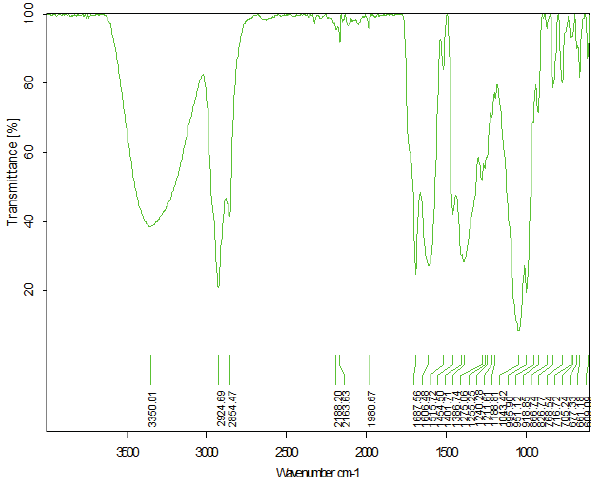
Figure 1. FTIR spectra of Sambucus canadensis in the range of 4000 to 600 cm -1